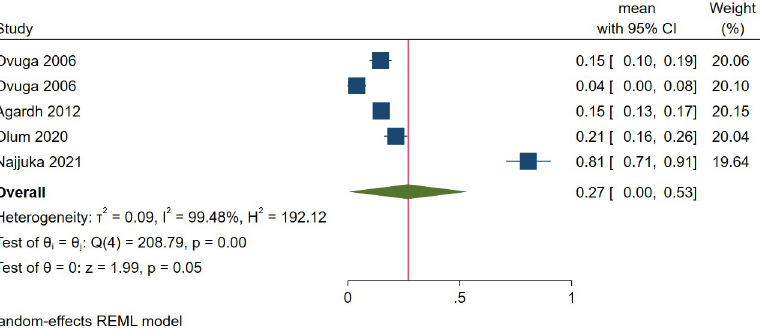
Fig 11. Forest plot on the prevalence of depression among university students in Uganda.